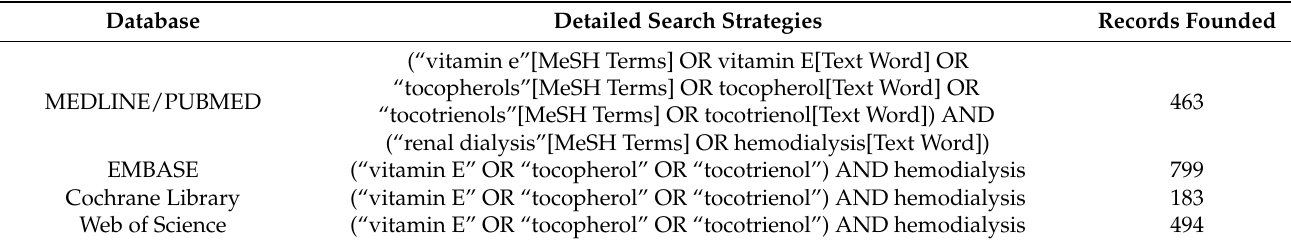
Table A1. Detailed search strategies for each database. MeSH terms, search terms, and combinations of the two were used for each database